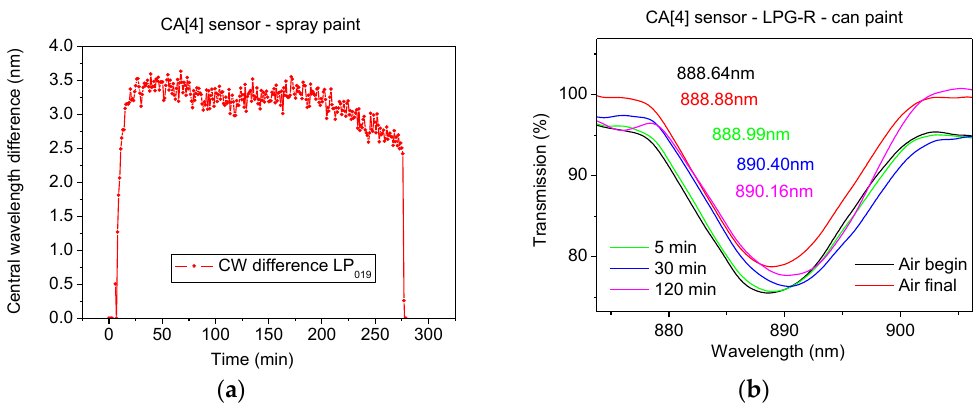
Figure 8. ( a ) Dynamic change of CA[4] sensor during the spray paint experiment and ( b ) CA[4] sensor—LPG-R—can paint experiment—TS—initial one ( black ), final one ( red ) and 5 min ( green ), 30 min ( blue ) and 120 min ( pink ) after the paint placement.